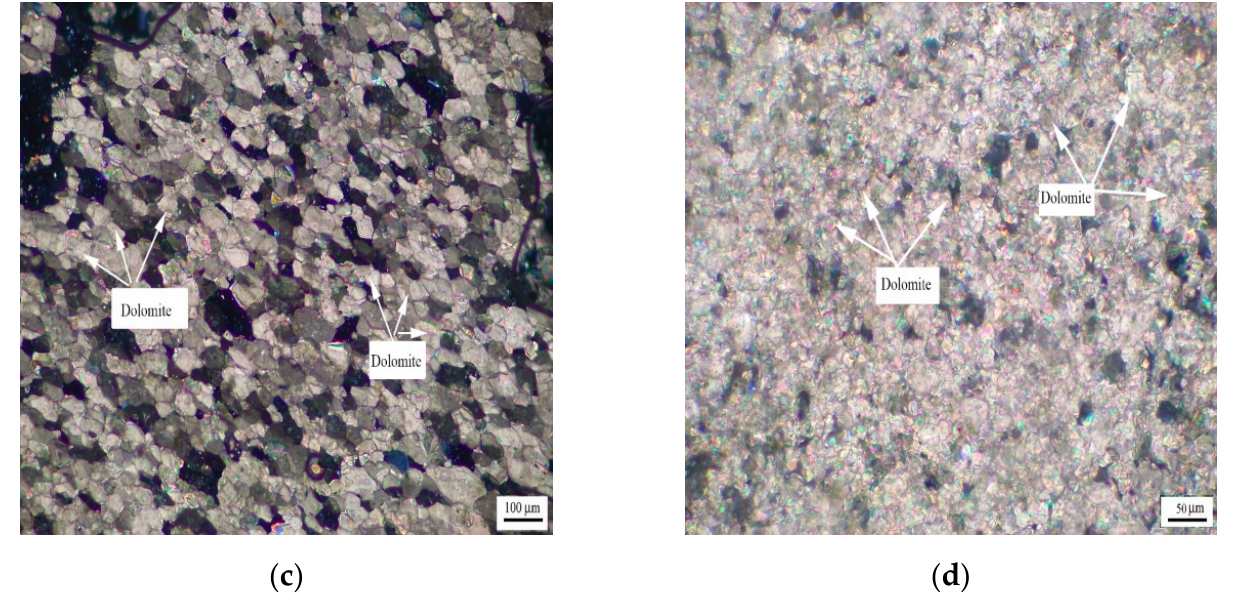
Figure 6. Distribution of dolomites in Devonian rocks ( a ) SFP-1, ( b ) SFP-2, and ( c ) SFP-3.